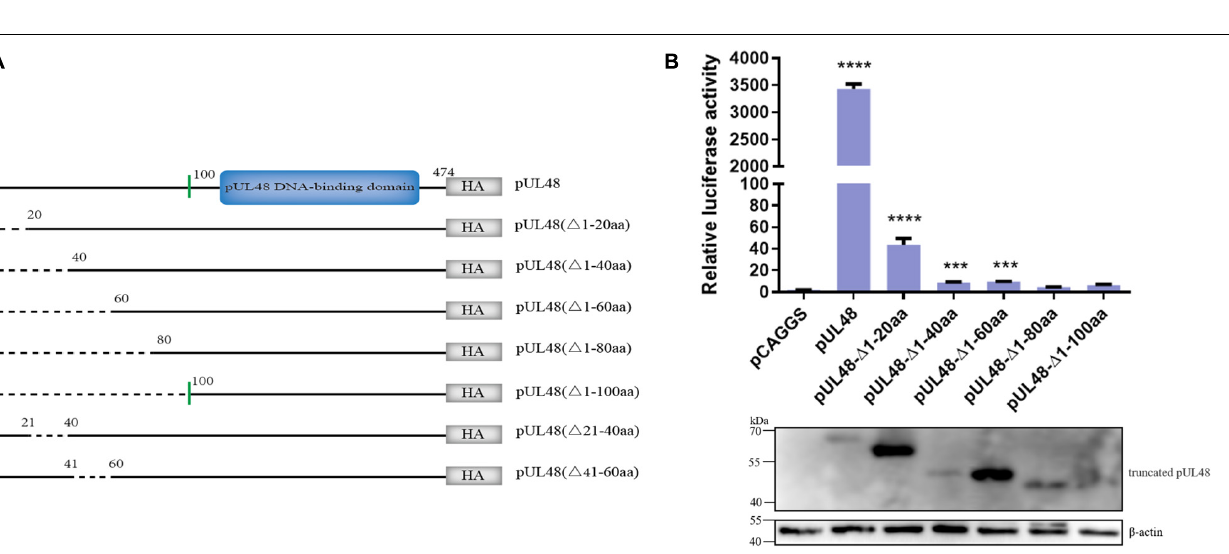
FIGURE 4 | Effect of pUL48-truncated protein on ICP4 promoter activity. (A) Structure diagram of N-terminal-truncated protein of pUL48. (B) Regulatory effects of pUL48 N-terminal-truncated protein on ICP4-Pro (1,235 bp). The pUL48 N-terminal-truncated plasmid was cotransfected with ICP4-Pro (1,235 bp) and pRL-TK into DEF. At 24 h after transfection, cell samples were collected, and the activity of each promoter was detected by the dual-luciferase reporting system. The pUL48 N-terminal-truncated plasmid was transfected into DEF. At 24 h after transfection, cell protein samples were collected for Western blot analysis. Student’s t -test was used to analyze the control and the differences of each experimental group. *** p < 0.001, **** p < 0.0001.